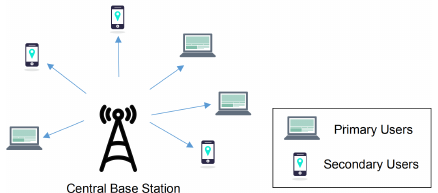
Figure 1. Illustration of the centralized CRN scenario.